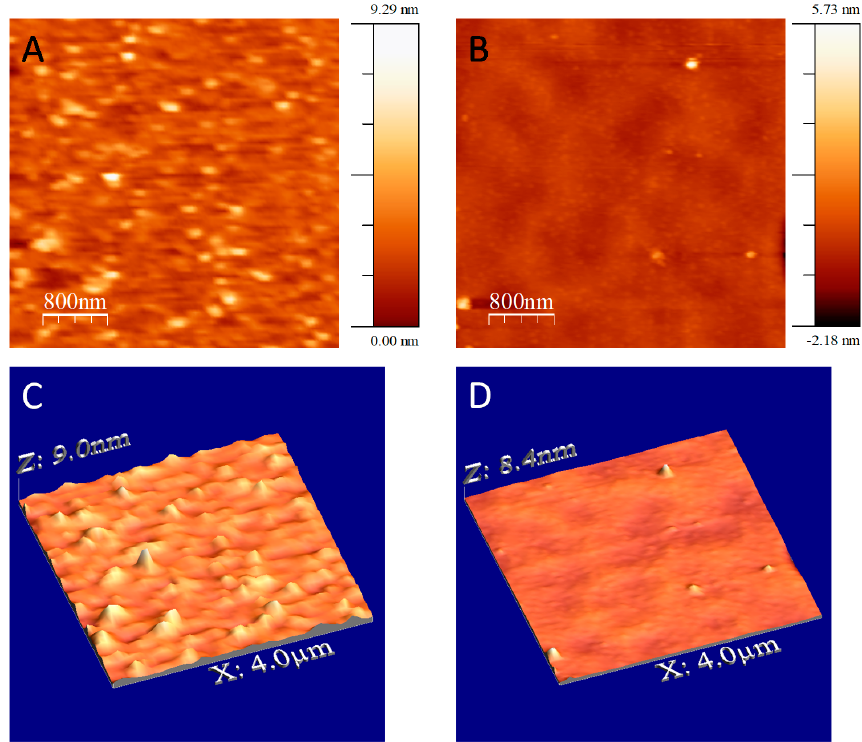
Figure 5. AFM images of native-SiO 2 ( A , C ) and sputtered-Si ( B , D ) substrates after the deposition of the catalyst and heating to 673 K.